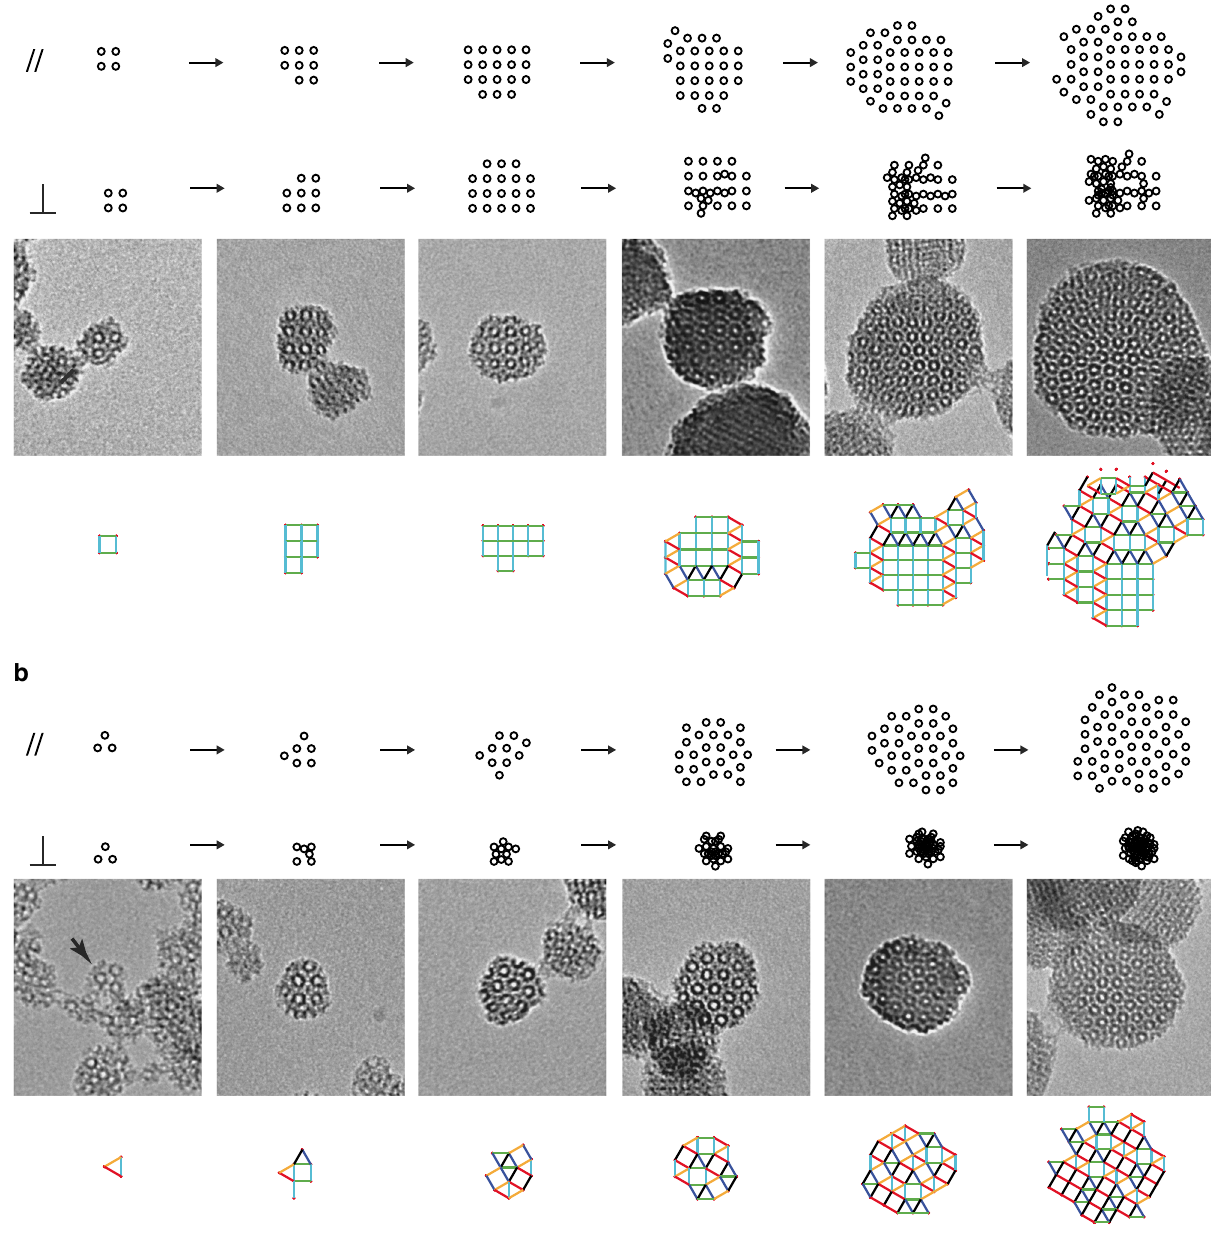
Fig. 6 Comparison of simulated growth trajectories with TMOS/APTMS-derived MSNs. a , b Single-particle growth trajectories of two simulated particles with input triangle/square ratio equal to 0.1 with vertices plotted in both parallel and perpendicular space. Simulated growth stages are compared to experimental TEM images of TMOS/APTMS-derived MSNs and their tilings. Particles were synthesized under varying ammonium hydroxide and mesitylene concentrations as shown in Fig. 2e. The stirring rate was 600 rpm for all syntheses. All images have the same magni fi cation; scale bar is 100